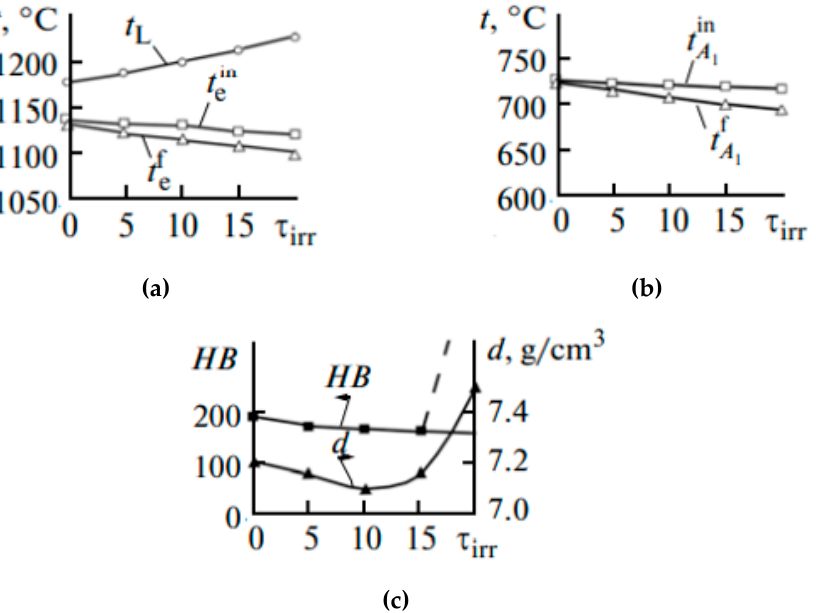
Figure 19. Influence of the irradiation time ( τ irr, sec) by electromagnetic pulses on the metal prop- erties [48]: ( a ) the temperature of crystallization, the beginning and end of the eutectic transfor- mation; ( b ) the beginning and end of the eutectoid transformation; ( c ) hardness and density.